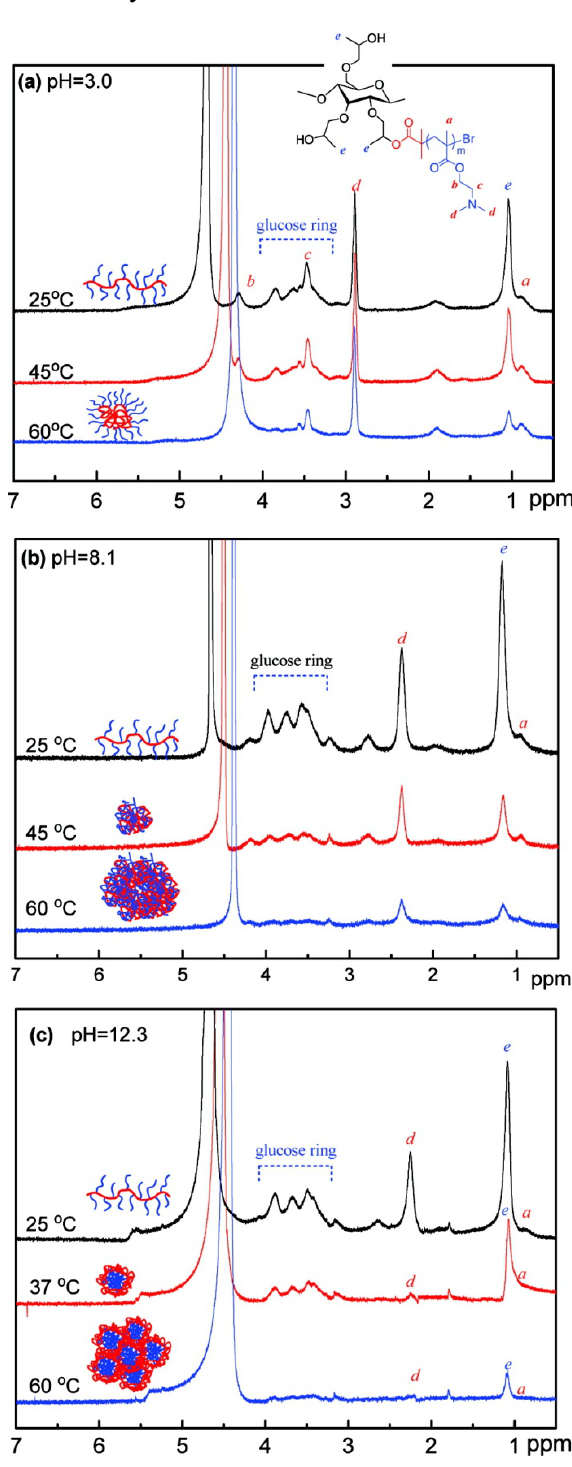
Figure 16. Temperature dependence of 1 H NMR spectra of HPC- g -PDMAEMA solutions O at pH ( a ) 3.0; ( b ) 8.1; and ( c ) 12.3. Reprinted with permission from [53]. Copyright in D 2 2010 American Chemical